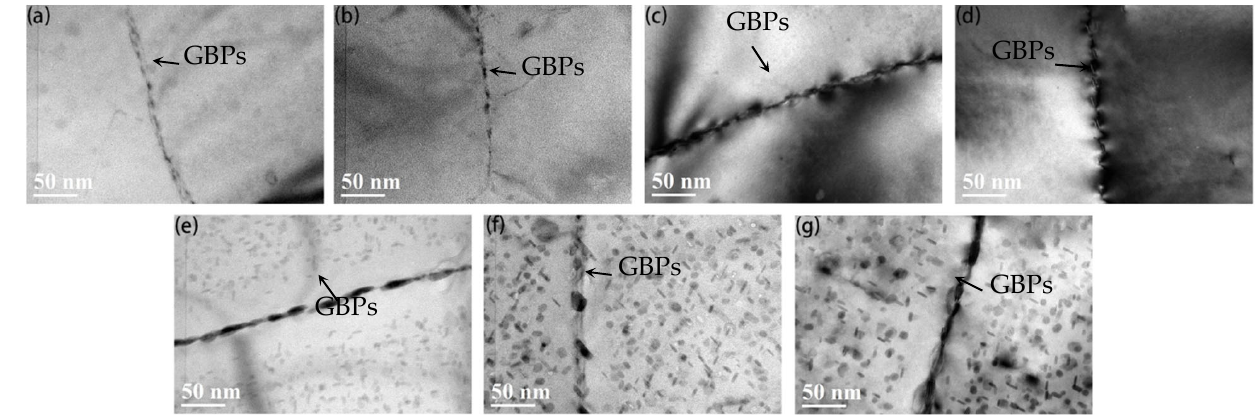
Figure 4. Bright ‐ field transmission electron microscopy (BF ‐ TEM) images of 7005 aluminum alloy Figure 4. Bright-field transmission electron microscopy (BF-TEM) images of 7005 aluminum alloy plate grain boundary precipitates aged at 120 °C for different durations: ( a ) 1 h, ( b ) 4 h, ( c )8 h, ( d ) 12 plate grain boundary precipitates aged at 120 ◦ C for different durations: ( a ) 1 h, ( b ) 4 h, ( c )8 h, ( d ) 12 h, h, ( e ) 24 h, ( f ) 96 h, and ( g ) 192 h. ( e ) 24 h, ( f ) 96 h, and ( g ) 192